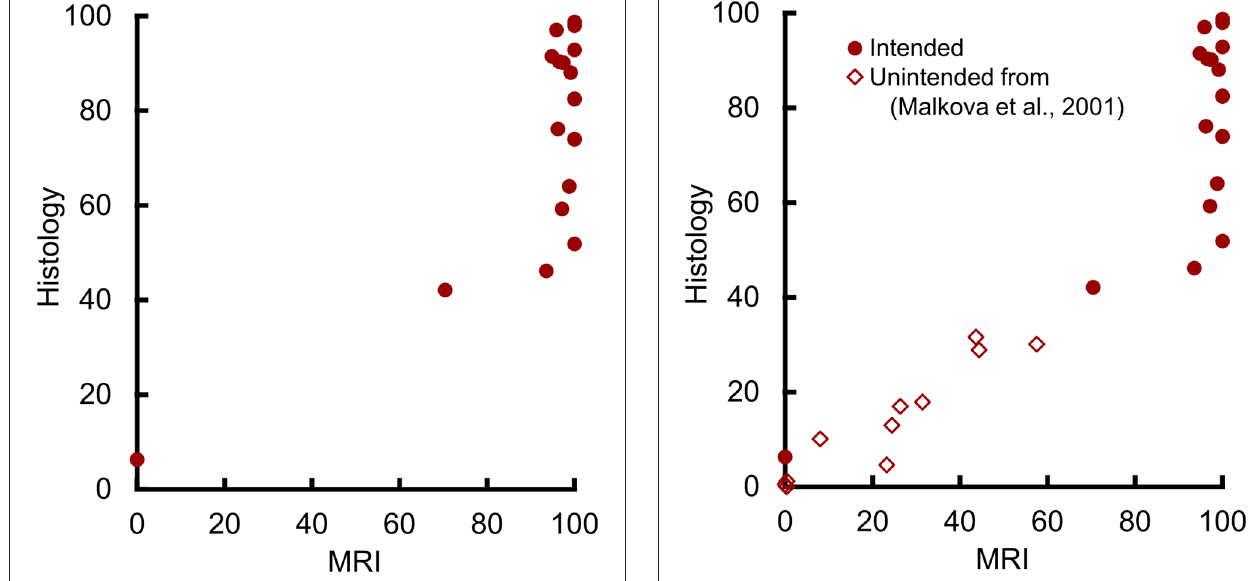
d = 0.71), and hippocampus ( t ( 18 ) = 4.23, p <